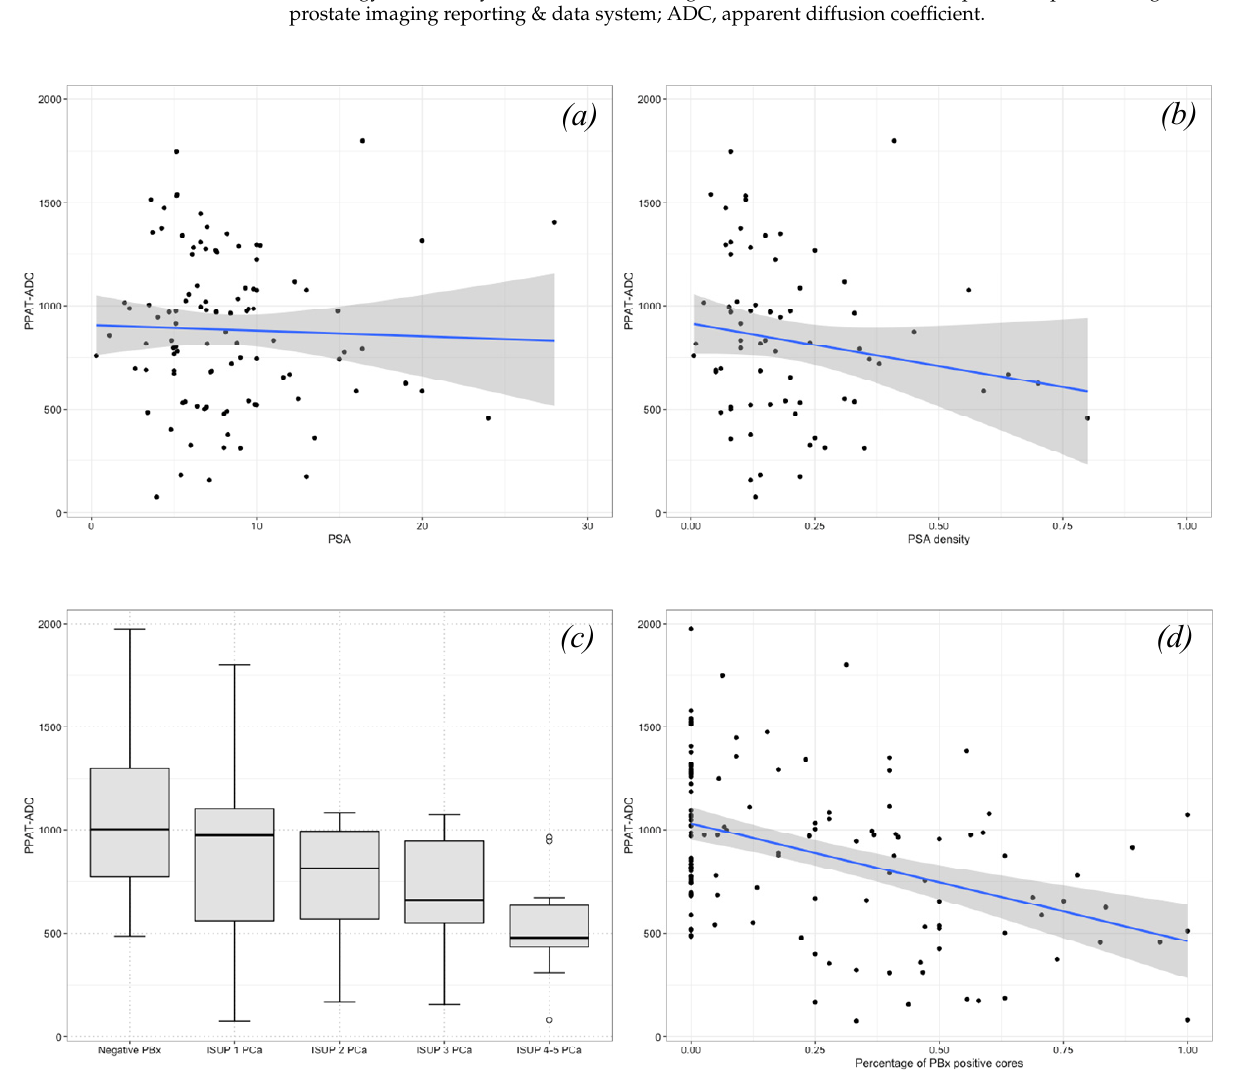
Figure 2. Scatter plots and box plots illustrating the relationship between periprostatic adipose tissue (PPAT)—apparent diffusion coefficient (ADC) values and ( a ) PSA, ( b ) PSA density, ( c ) ISUP grade group, and ( d ) percentage of prostate biopsy (PBx) positive cores. PPAT-ADC values decreased for higher PSA, PSA density, ISUP grade group, and percentage of PBx positive